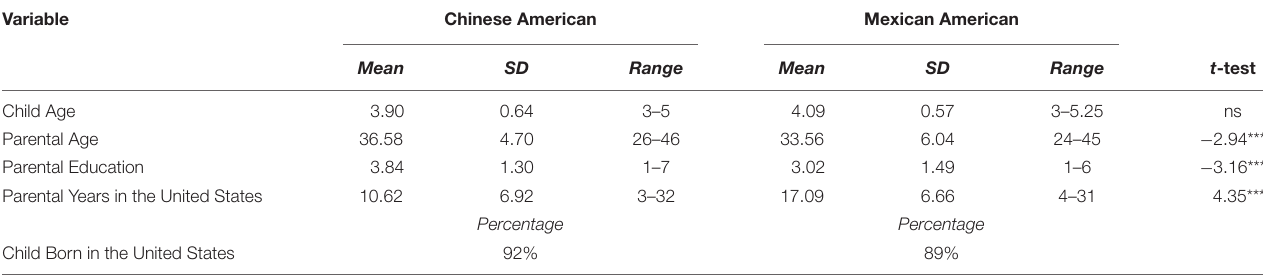
TABLE 1 | Descriptive statistics of demographic